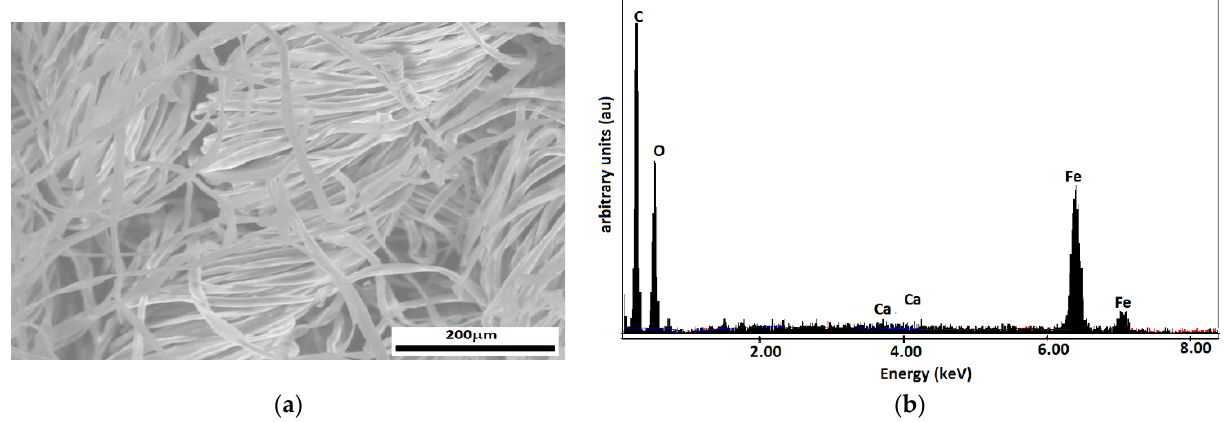
Figure 3. ( a ) SEM image of cotton fibers with ML. ( b ) Spectral analysis of cotton fabric with ML.